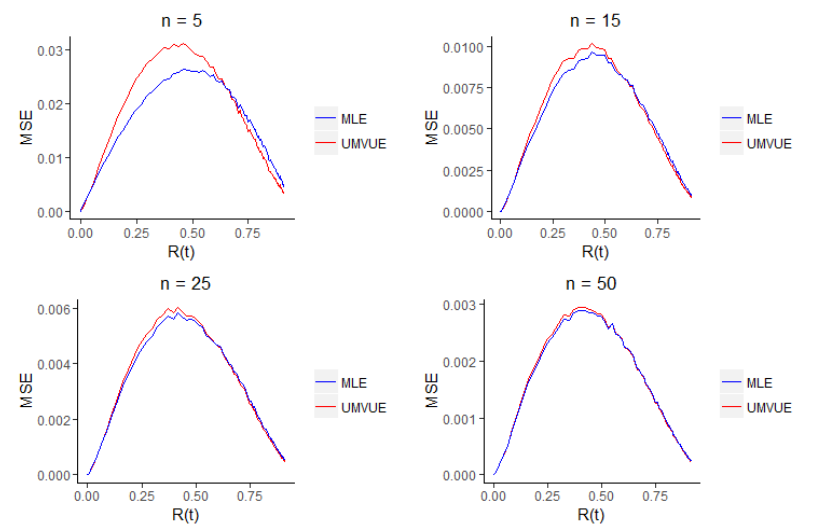
Figure 3 – MSE of the UMVUE and MLE of R ( t ) for different sample sizes.